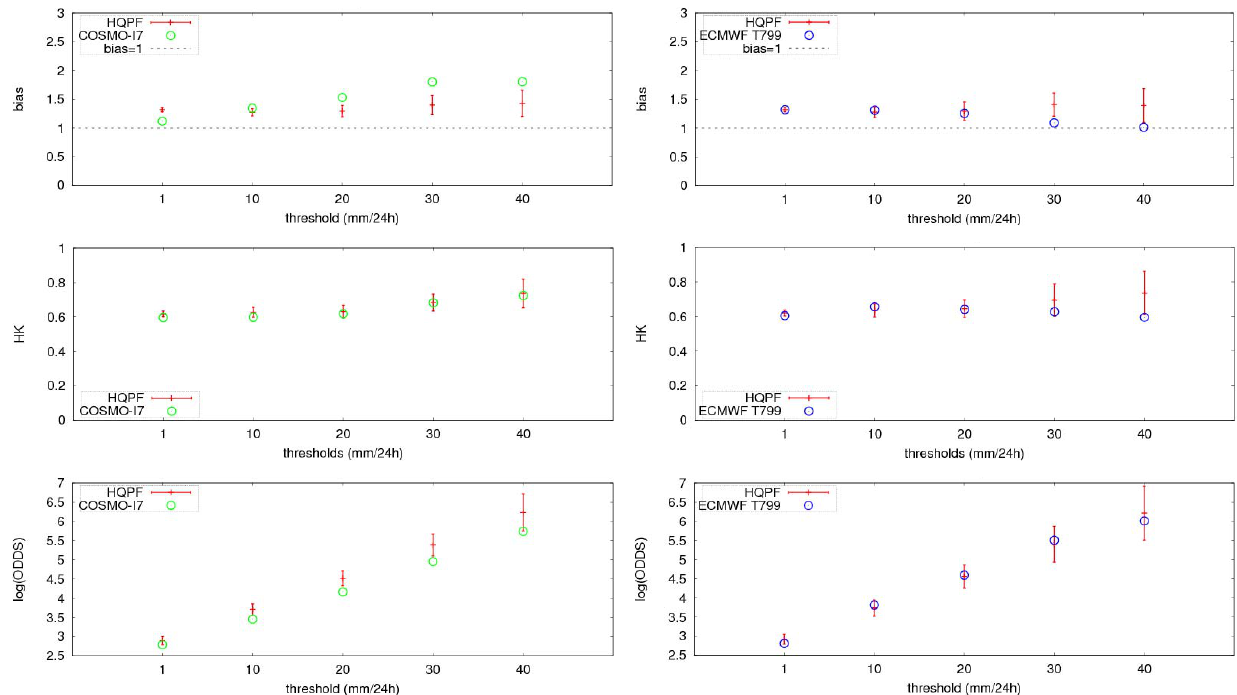
Fig. 2. Indices relative to QPFA (see text for explanation) in the interval +24h/+48h as a function of the threshold. In the left column there is the comparison between HQPF (in red) and COSMO-I7 (in green), while in the right column the comparison between HQPF (in red) and IFS (in blue). The BIAS score, HK score, and ODDS ratio score in logarithmic scale are indicated in the top line, middle line and bottom line panels, respectively. The plotted error bars indicate 2.5th and 97.5th percentiles of a resampled distribution for the difference